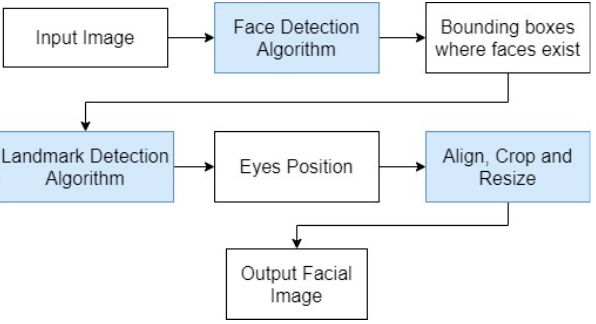
Figure 3. Flowchart of the steps of a facial detection and alignment module.